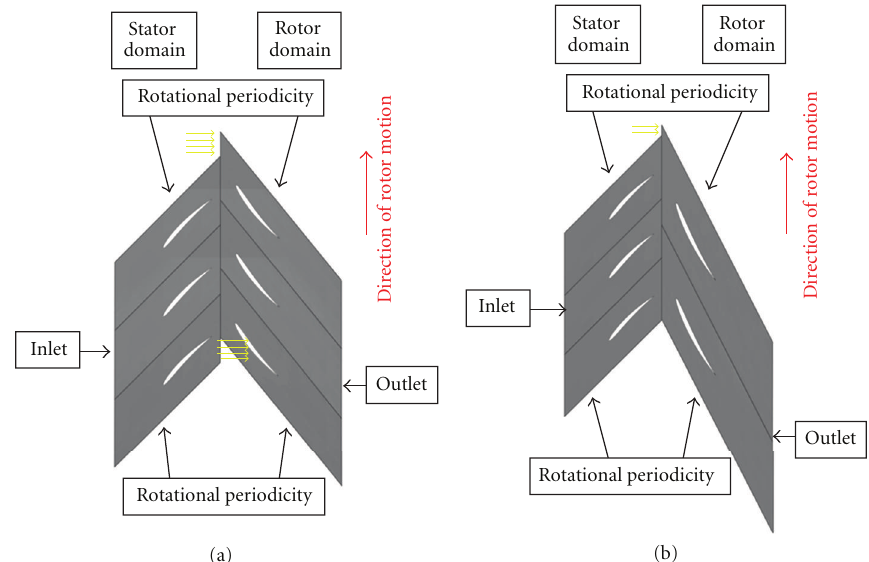
Figure 2: Modelling of rotor/stator domains requires the lowest common multiple of rotor/stator blades to be modelled for continuity of flow out of one domain and into another. (a) Integer pitch ratio, all flow out of stator domain flows back into rotor domain (b) noninteger pitch ratio, has unequal flow from stator to rotor